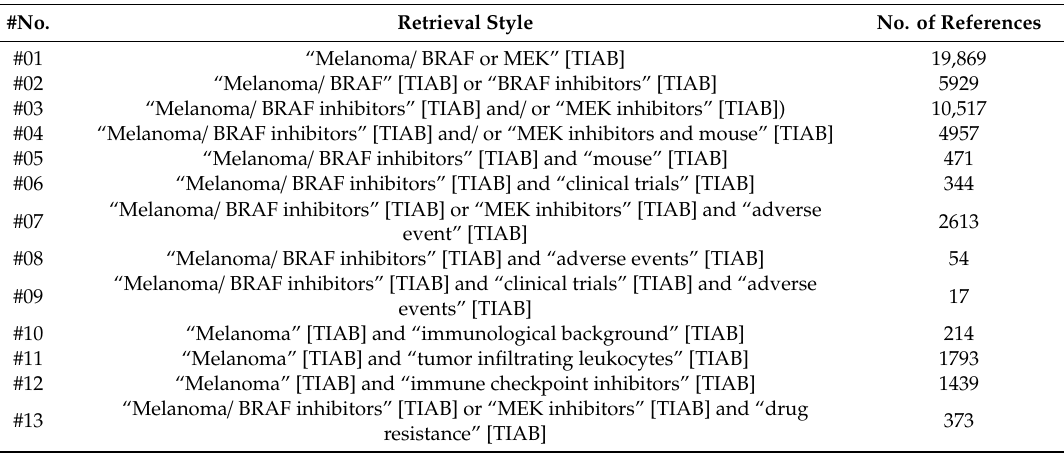
Table 1. Search Strategy for the Literature